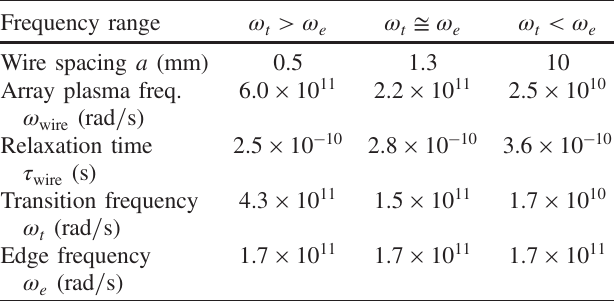
TABLE II. Parameters of rectangular arrays of parallel wires for three wire spacings. The wire conductivity is σ 6 . 3 × 10 7 S = m, and the wire radius is r ¼ 1 μ m for all three spacings. The image field duration or transit time is σ The applied field is 50 MV =